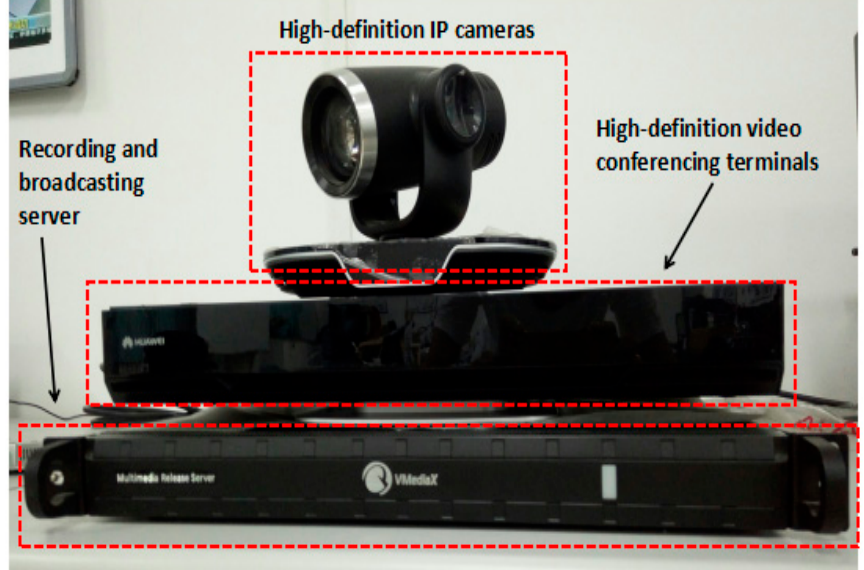
Figure 8. Remote operation interactive system.